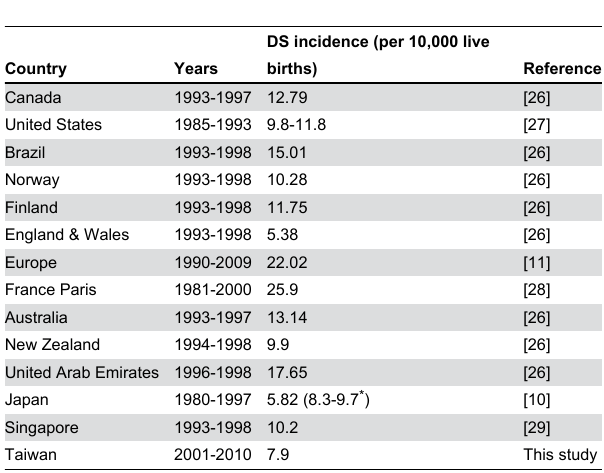
Table 3. Incidence of Down